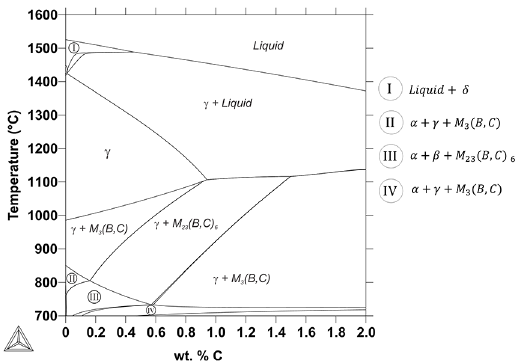
Figure 5. Isopleth simulation of alloy compositions from Table 1.